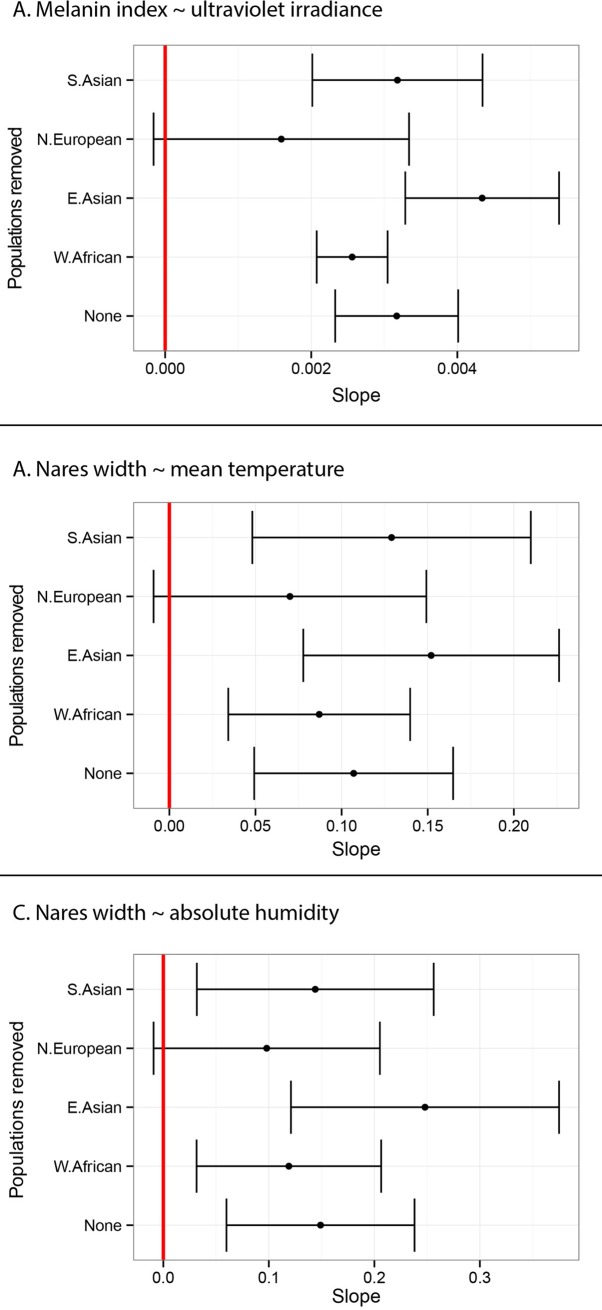
The effect of removing each population on phenotype-climate correlations.The point estimate and the 95% confidence intervals of the phenotype-climate slopes after removing each population (on the y-axis) are shown for A) skin pigmentation and UVB, B) nares width and temperature, and C) nares width and absolute humidity. In all cases, the 95% confidence interval of the slope overlaps with zero (red vertical line), only when the Europeans are removed.